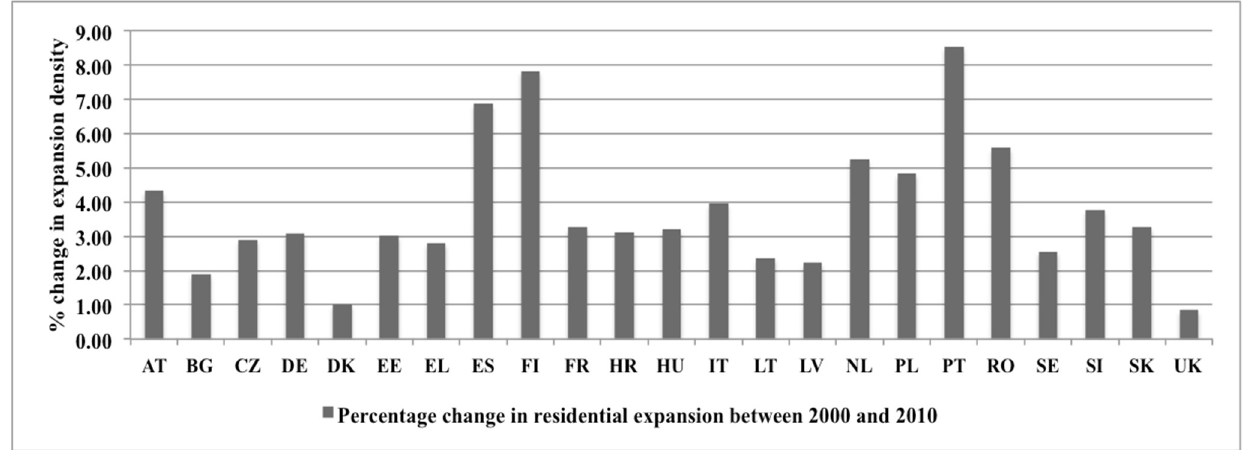
Figure 3. Percentage change in residential expansion densities between 2000 and 2010 in declining regions in Europe. Note: Belgium, Cyprus, Ireland, Luxembourg, and Malta are not included in the figure, considering that there are no declining regions in these countries.